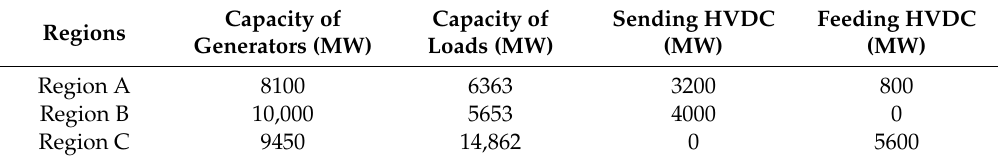
Figure 12. Topology of test system 2. Table 3. Specific information of regions.